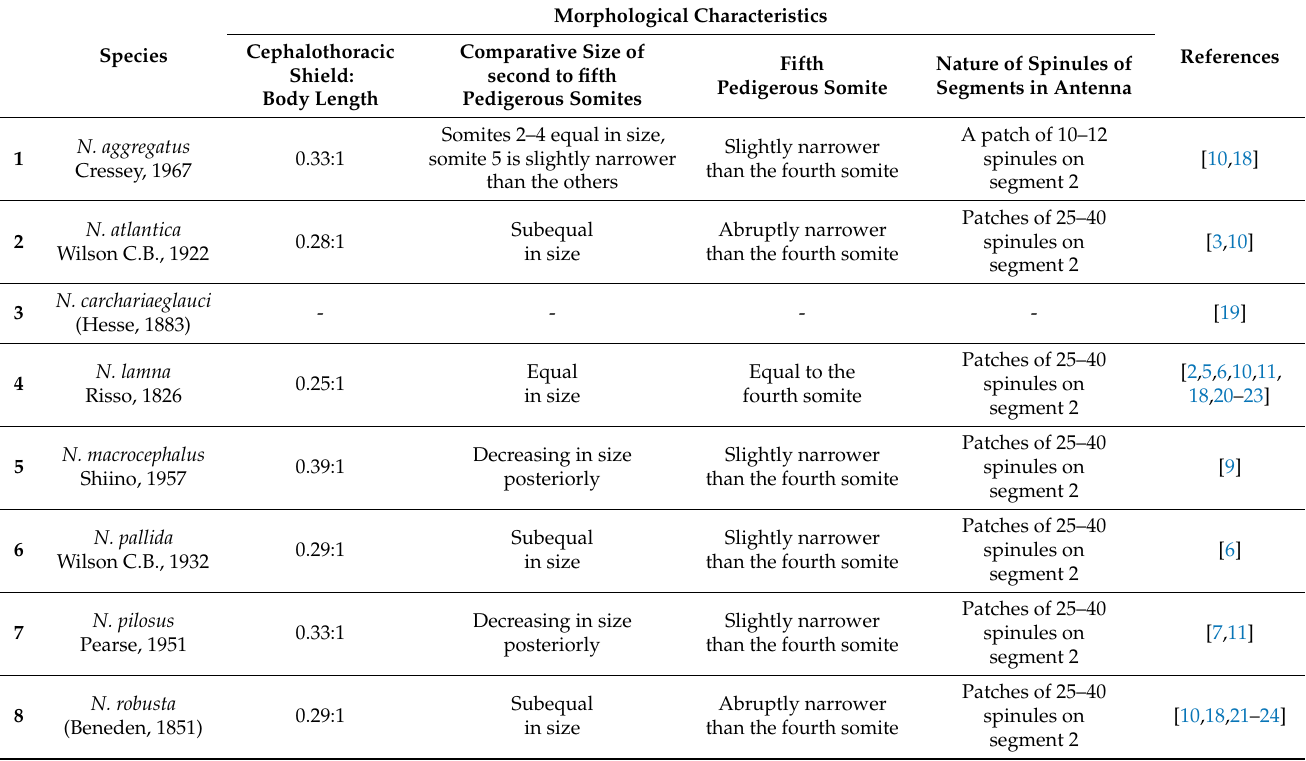
Table 2. Inter-specific characteristics between the species of Nemesis Risso, 1826. Morphological Species